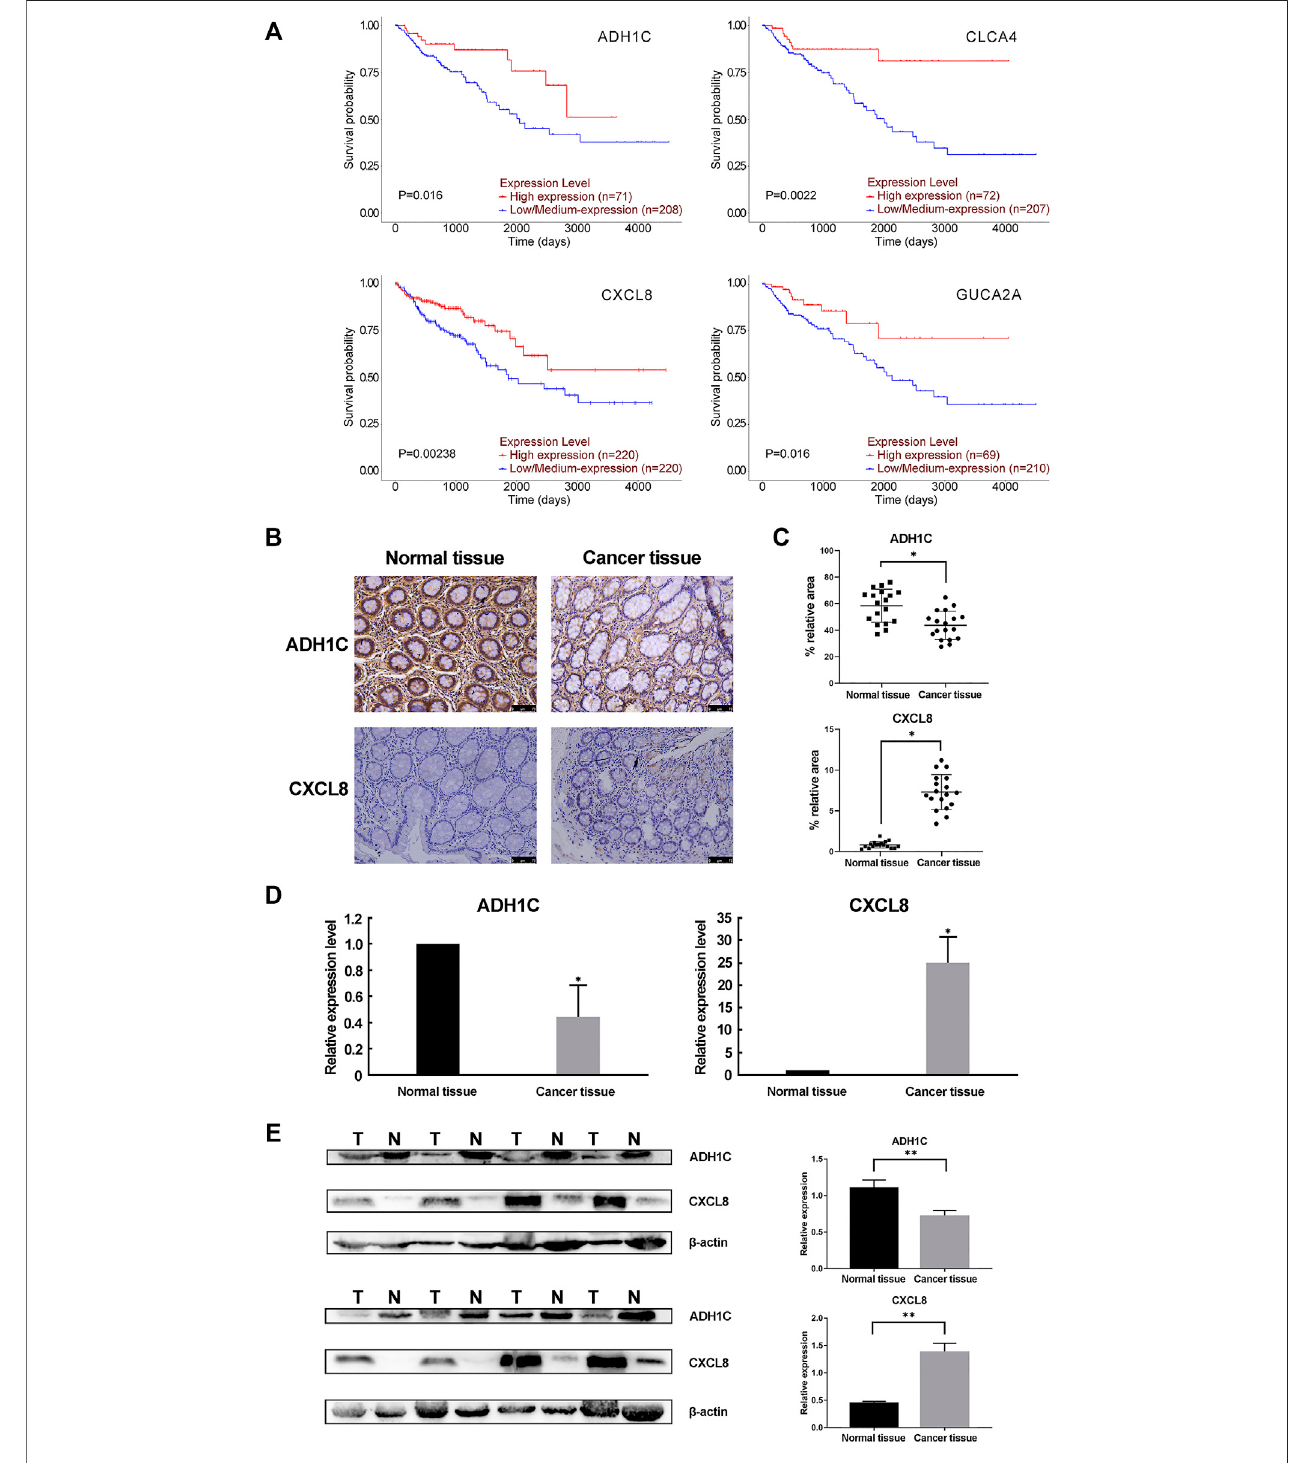
FIGURE 4 | The prognostic analysis and the protein level of the hub genes. (A) UALCAN and OncoLnc online resources were applied to obtain the prognostic results of the 13 hub genes. Only four of the 13 hub genes had signi fi cantly lower overall survival rates ( P < 0.05). (B,C) Immunohistochemistry (IHC) analysis of CRC tissue and adjacent normal tissue. (B) showed the representative DAB IHC staining with ADH1C, CXCL8 antibody, and cell nuclei stained by hematoxylin of cancer and normaltissue pathologyslides. (C) showedthequantitativeanalysisresultsbyImageJandIHC Toolboxplugin.Themagni fi cation ofthe fi eldis×100,and thescale bar is 75 μ m. (D) Real-time PCR results con fi rmed the dysregulation of the mRNA expression of ADH1C and CXCL8. (E) The protein level of ADH1C and CXCL8 were detected by Western blot. T, tumor tissue; N, normal tissue. n = 8. ** P < 0.01 or * P < 0.05 by paired t-test.